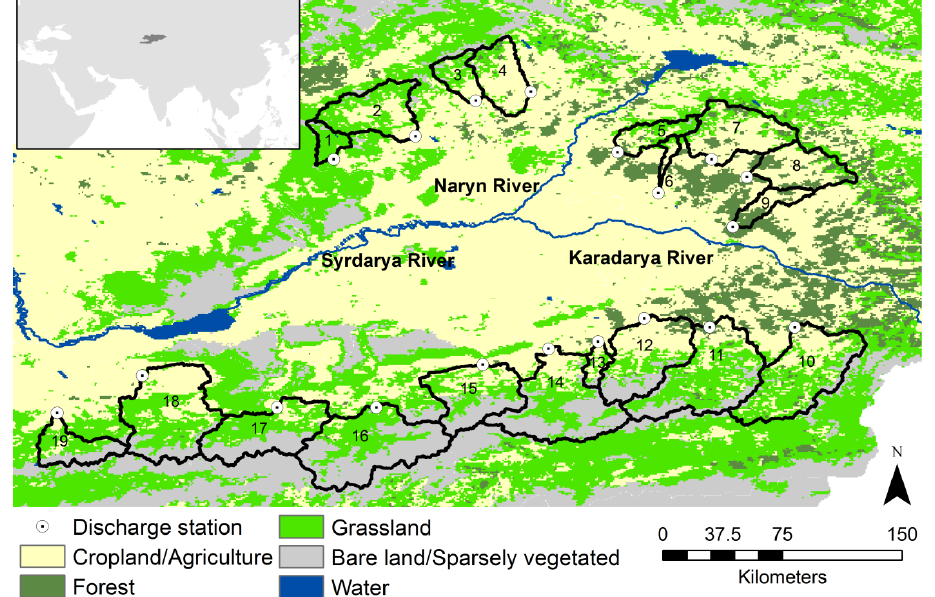
Figure 1. The Ferghana Valley with FAO (Food and Agriculture Organization) land-use map and delineated upper catchments (in black) using SRTM (Shuttle Radar Topography Mission) DEM (Digital Elevation Model, 90 m) and ArcGIS (10) software (Redlands, CA,